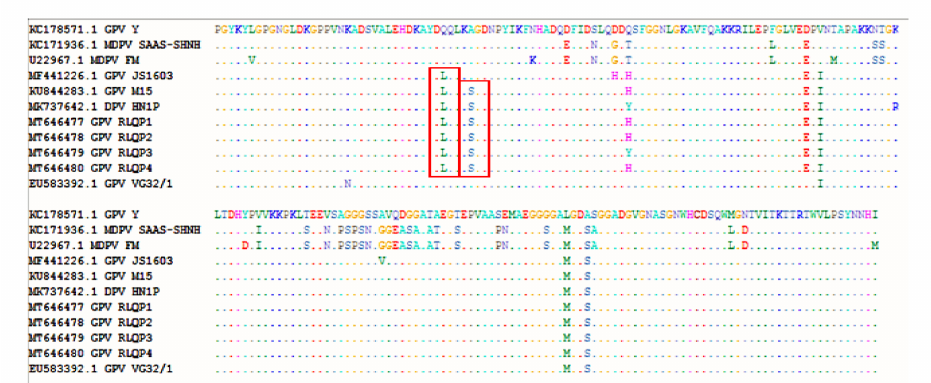
Figure 6. Amino acid alignment report created by Bioedit software showing close amino acids patterns of four RLQP (Reference laboratory for veterinary quality control on poultry production) strains with both Chinese NGPV strains (M15 and HN1P). Red bars are defining the Gln89Leu mutation that was present in NGPV strains, and the unique amino acid mutation (Ala93Ser) that was only recorded in the Egyptian NGPV strains and in two Chinese NGPV strains (M15 and